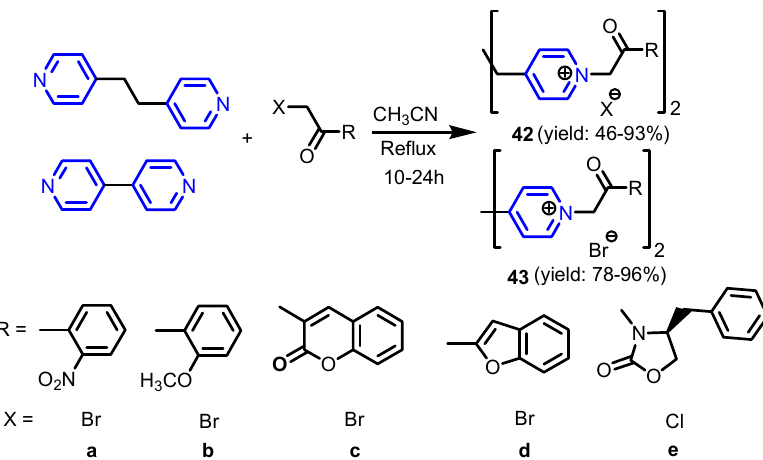
Scheme 8. Synthesis of bis-pyridinium quaternary ammonium salts [29].